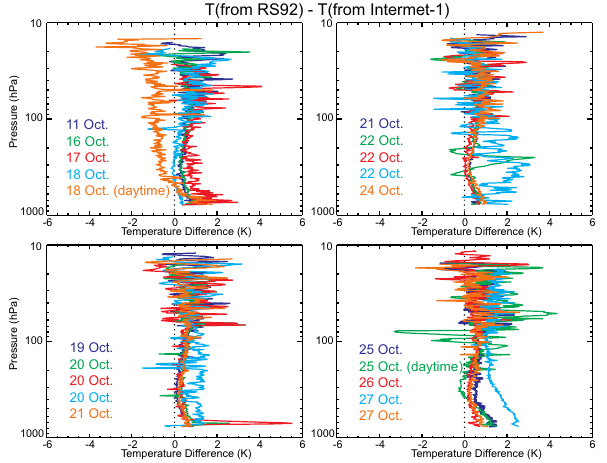
(cid:45)(cid:49)(cid:48)(cid:48) (cid:45)(cid:53)(cid:48) (cid:48) (cid:53)(cid:48) (cid:49)(cid:48)(cid:48) Fig. 4. Campaign-mean difference resulting from the systematic biases between RS92 and iMet-1 radiosonde data. Orange: mean radiosonde temperature difference; green: mean geopotential height difference; dark blue: CFH-derived water vapor mixing ratio mean difference. The thick red horizontal and vertical bars denote layer- averaged differences and associated standard deviations. Only the 14 most consistent flights (out of 16) were used to compute these